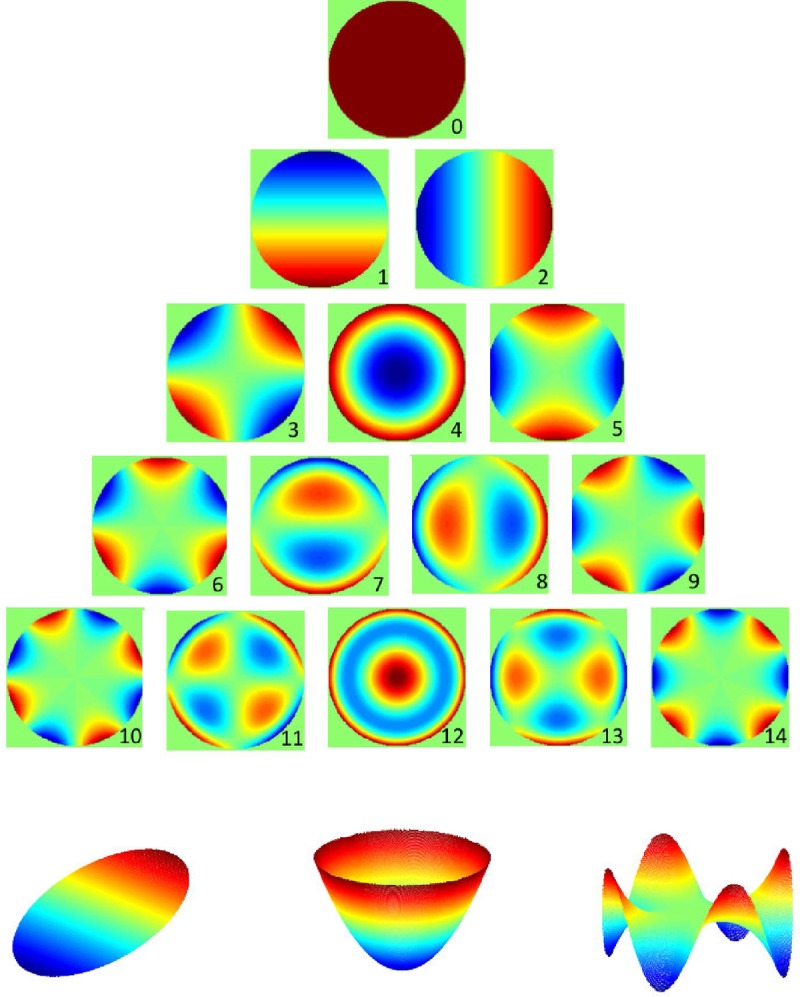
Visualisations of Zernike polynomials.Top: 2D visualisation of the first fifteen ZP on the unit circle. The numbers underneath the plots are ANSI sequential indices, see Eq (4). Bottom: 3D visualisations of ZP with indices 1, 3 and 14, representative of asymmetry, magnitude and irregularity of the periphery.